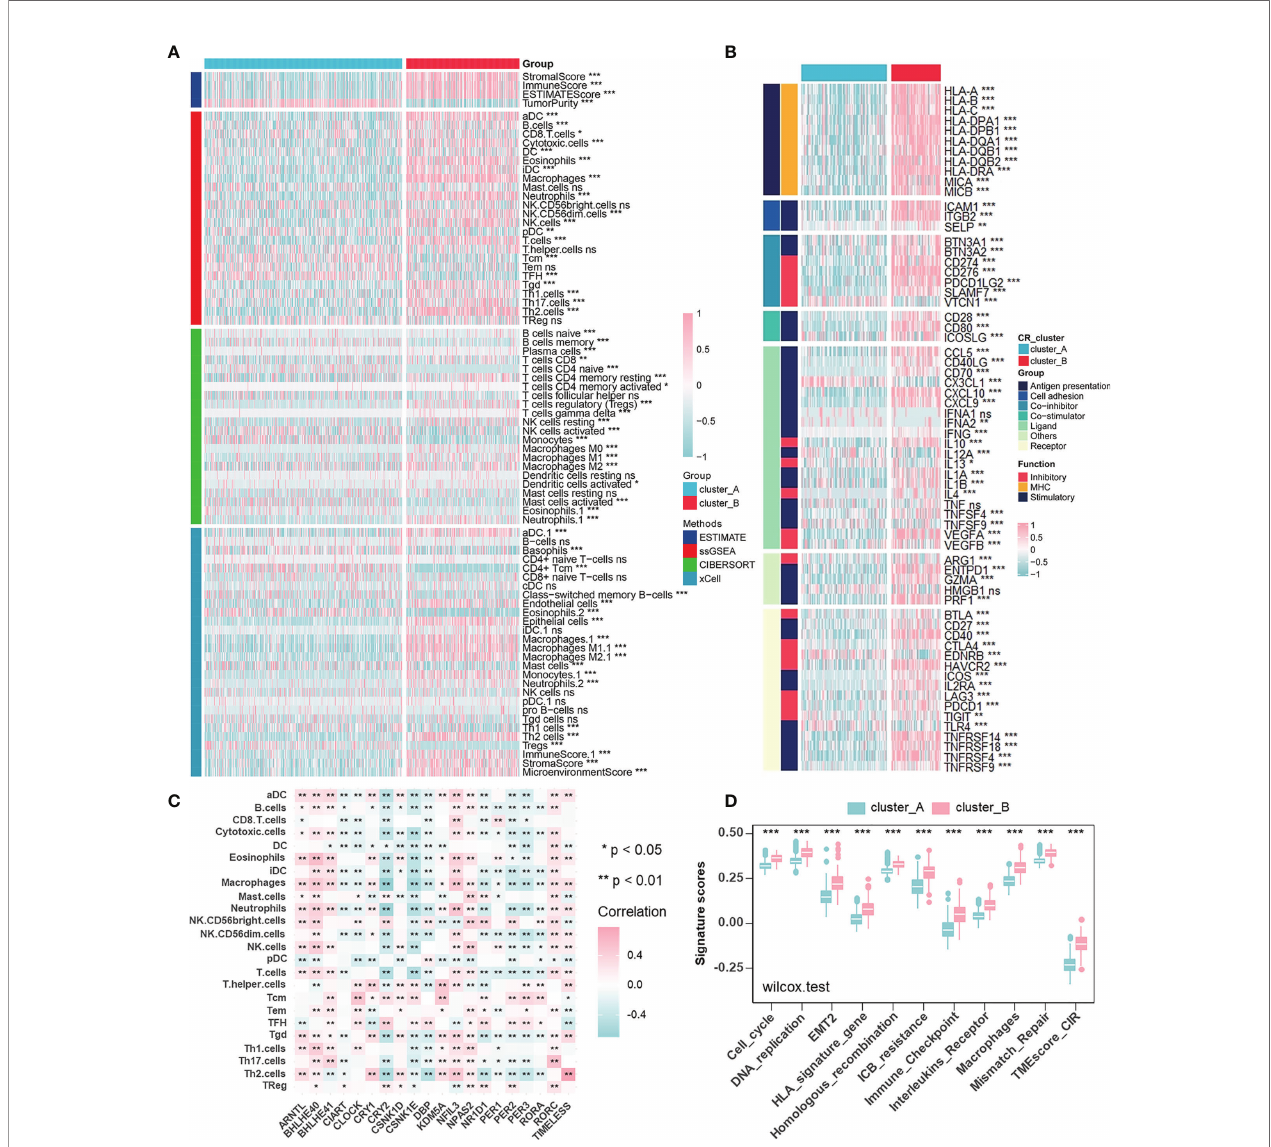
FIGURE 3 | Characterization of the immune cell in fi ltration in distinct circadian patterns. (A) Heatmap of TME cell in fi ltration characteristics in two CR patterns assessed by four different methods. (B) Heatmap showing the differences of immune-related gene expression in two CR patterns. Upregulation, pink; Downregulation, blue. (C) The correlation between TME in fi ltration cell type and each core CR genes using spearman analyses. Negative correlation, blue; Positive correlation, pink. (D) CR clusters were distinguished by different TME relevant signatures and TME score (Wilcoxon test: *** p <